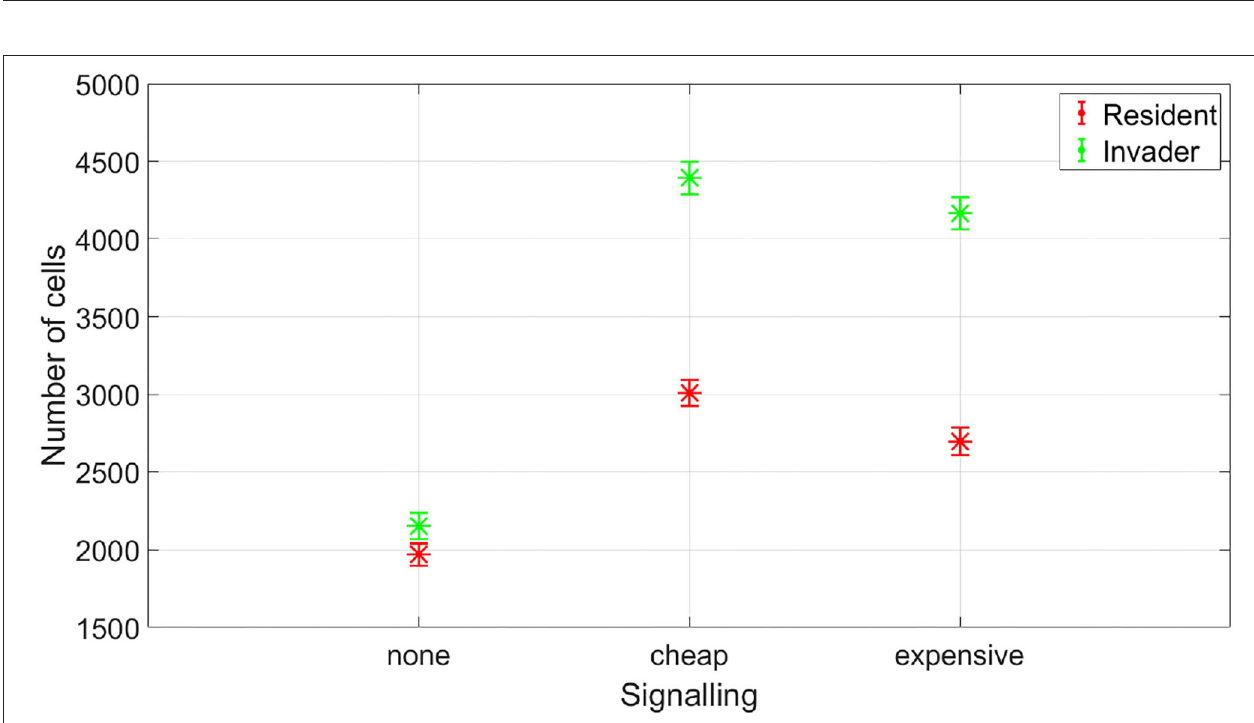
FIGURE 11 | The fitness of an efficient antibiotic producer vs. a resident species, at different signaling scenarios. While expensive signaling is costly for both the resident and the invader species, it ensures honest communication. The data representation is the same as Figure 4 .